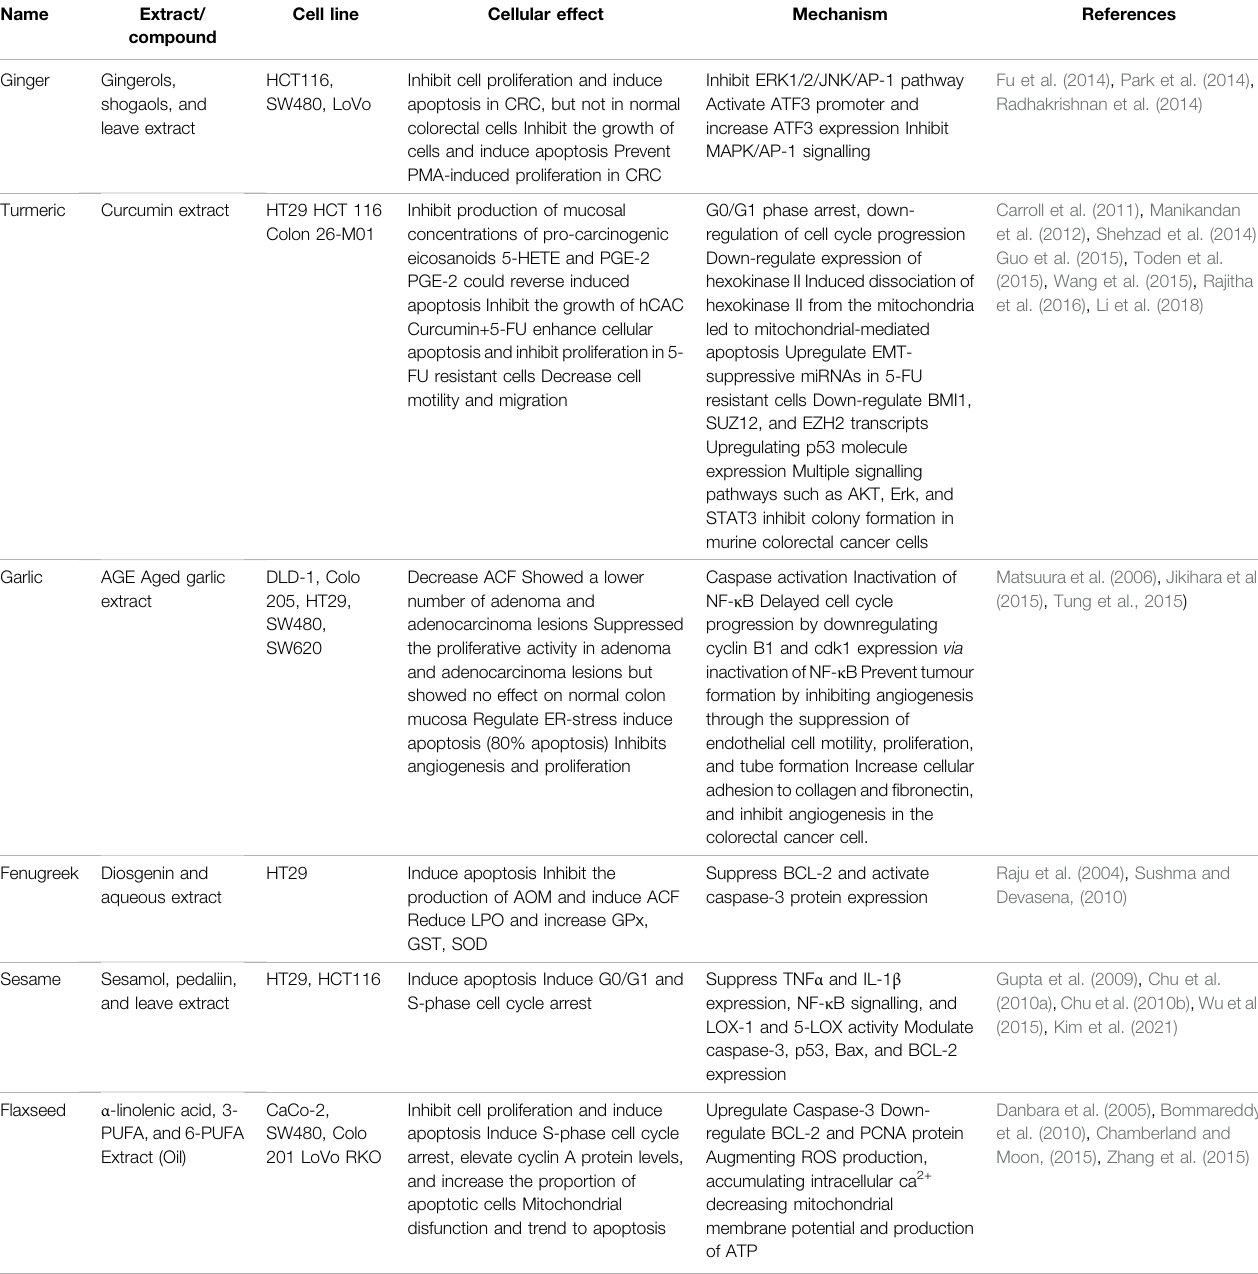
TABLE 2 | An overview of cytotoxic effects of culinary herbs and spices on colorectal